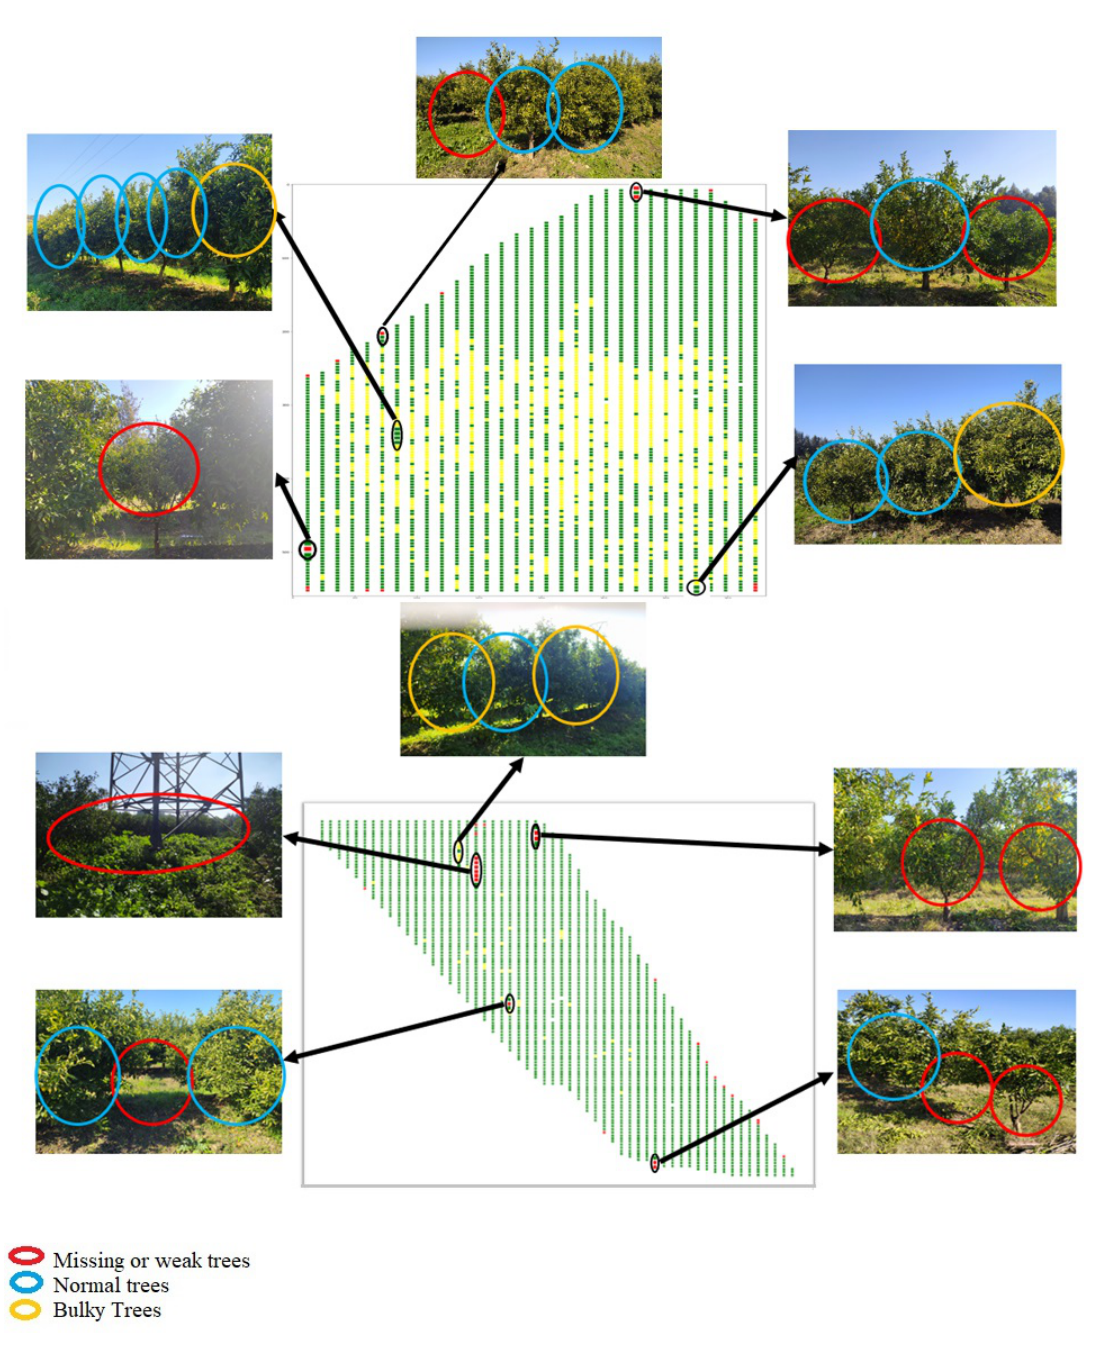
Figure 11. Comparison between tree classification in the map and field